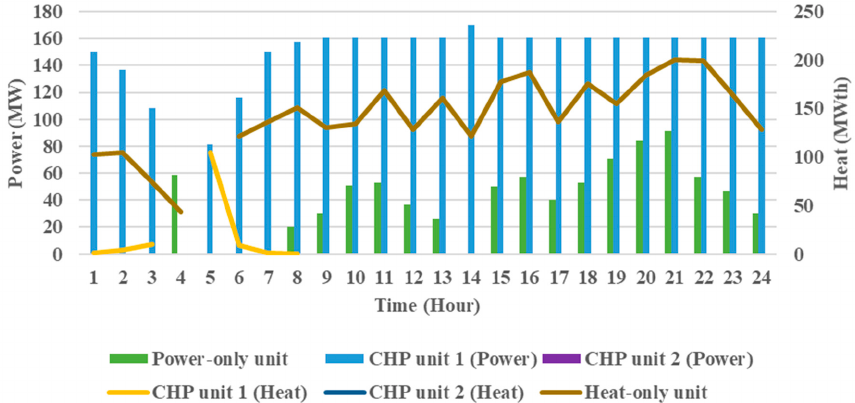
Figure 9. Short-term generation scheduling for a typical day in week 15. Table 7. Total cost of the short-term plan for a typical day in week 15.